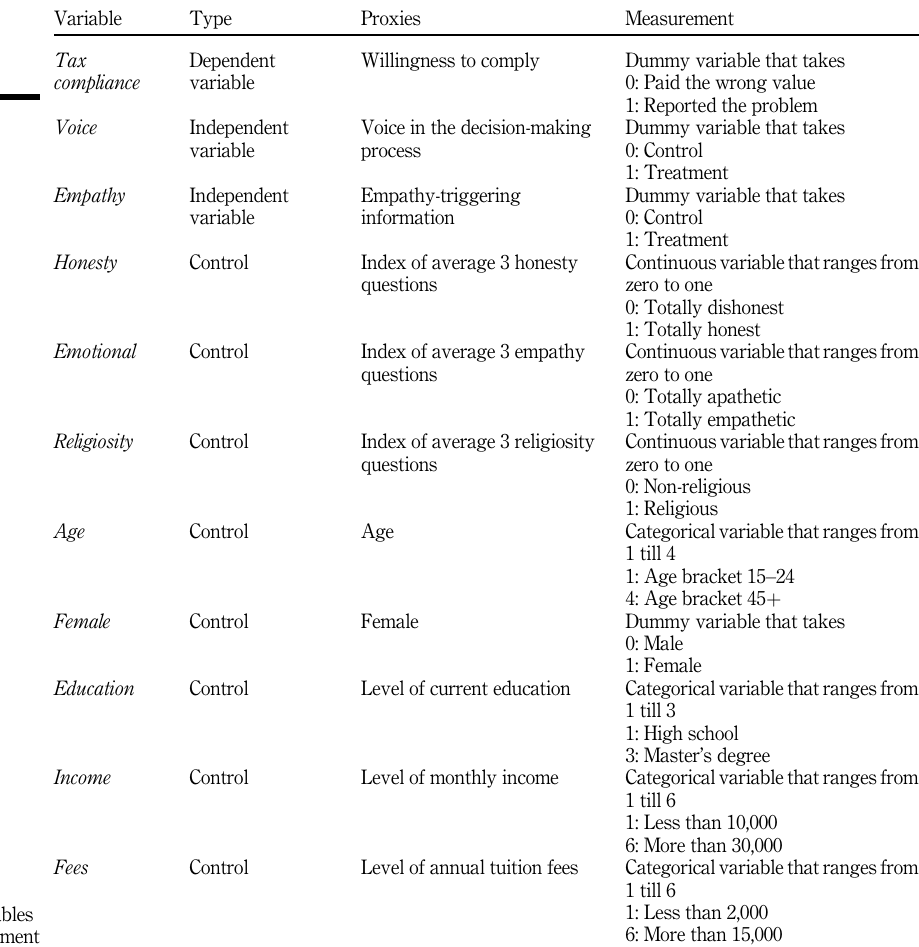
Table A1. Definition of variables and their